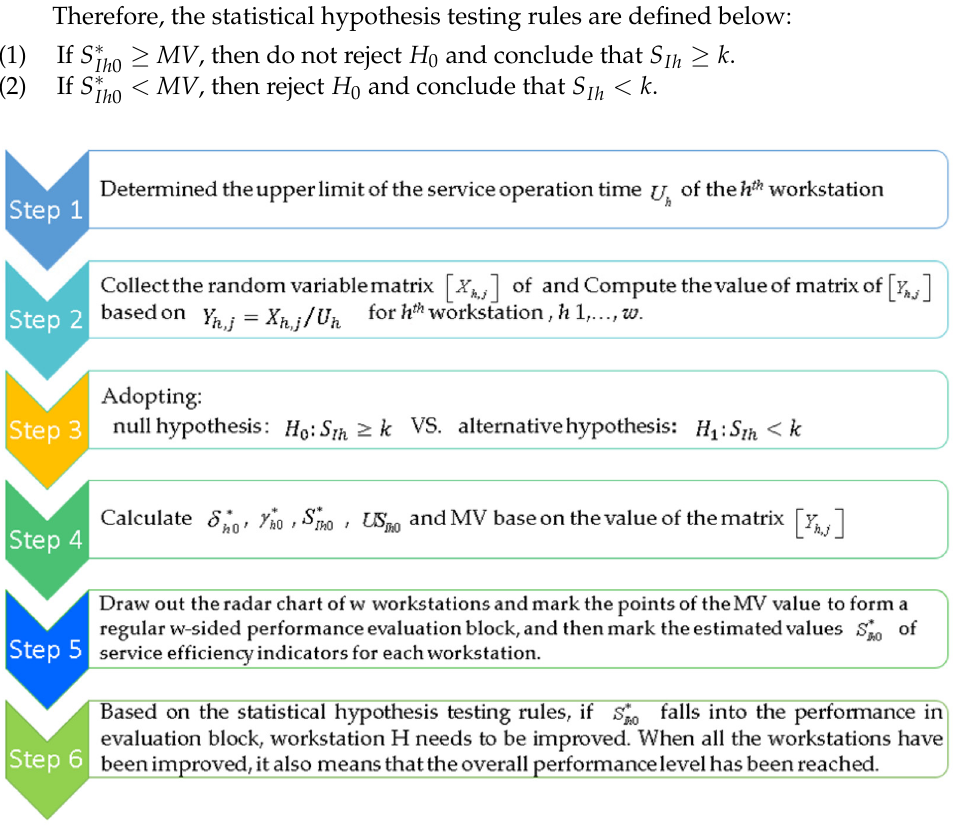
Figure 2. Flowchart of the service efficiency evaluation and management